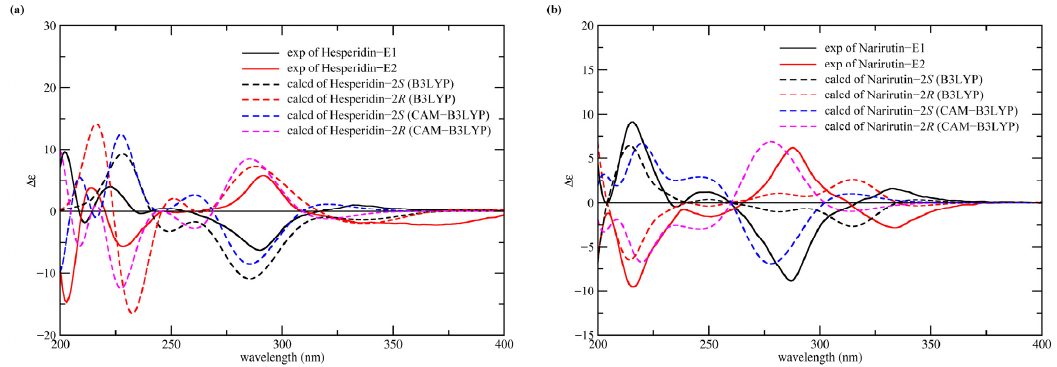
Figure 2. Experimental and calculated ECD spectra of the hesperidin ( a ) and narirutin ( b ) epimers.